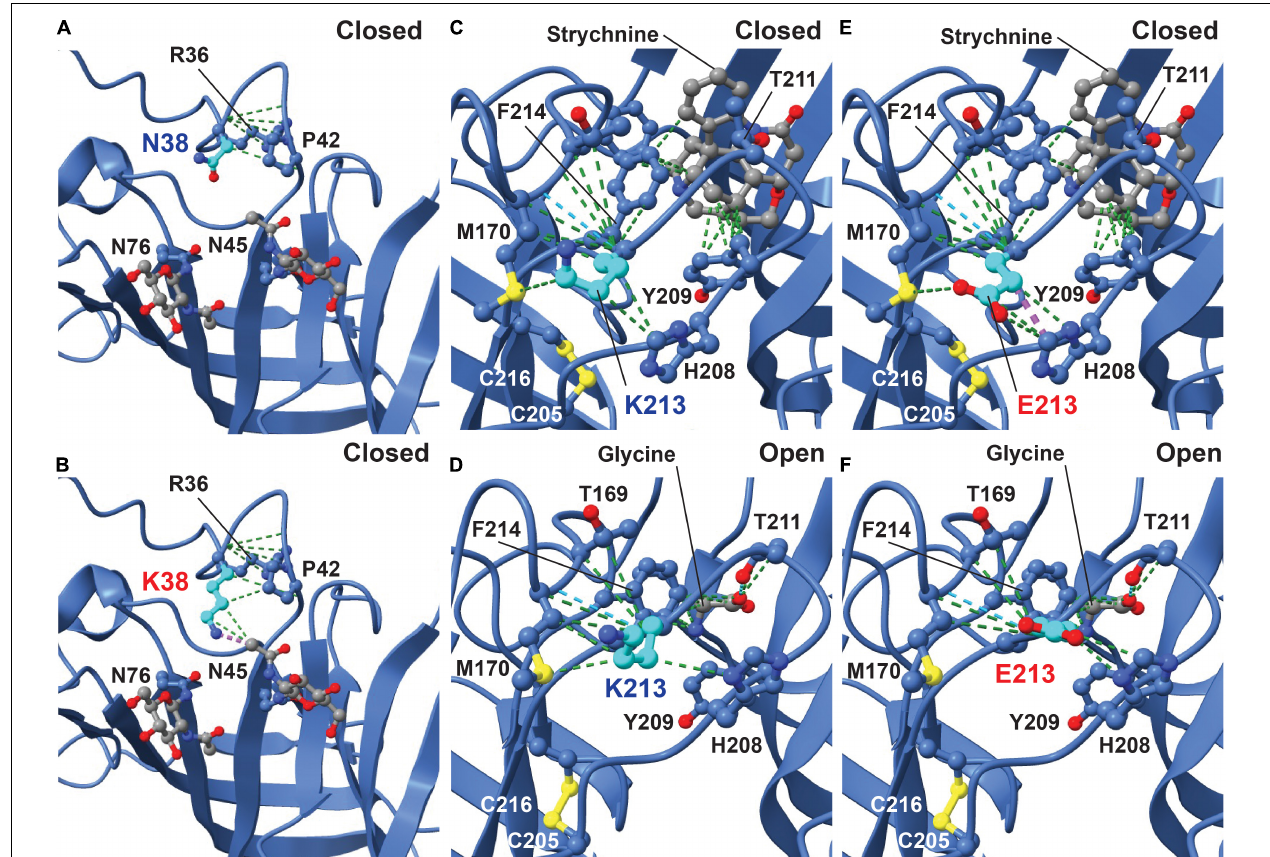
FIGURE 2 | Molecular modeling of the impacts of GlyR α 2 N38K and α 2 K213E variants. The potential effects of GlyR α 2 N38K and GlyR α 2 K213E variants were visualized using the GlyR α 2 β pentamer in the strychnine-bound closed state (RCSB: 7L31) and glycine-bound open state (RCSB: 5BKF) (Yu et al., 2021). In the closed state (A) , GlyR α 2 N38 makes contacts (green lines) with neighboring residues R36 and P42, while mutant GlyR α 2 N38K (B) is predicted to maintain the original contacts but results in clashes (purple lines) with the glycan at residue N45. In the closed state (C) , GlyR α 2 K213 makes numerous contacts with neighboring residues (green lines), stabilizing the cysteine loop structure formed by C205 and C216. However, in the open state (D) , GlyR α 2 K213 forms stabilizing contacts with the loop and the ligand-binding residue F214 (green lines). In the closed state (E) , mutant GlyR α 2 K213E is predicted to clash with H208 on the opposing side of the cysteine loop (purple lines). Interestingly, in the open state (F) the GlyR α 2 K213E variant increases the number of contacts with neighboring residues, but does not show a clash with H208, suggesting that the open state may be favored for α 2 K213E